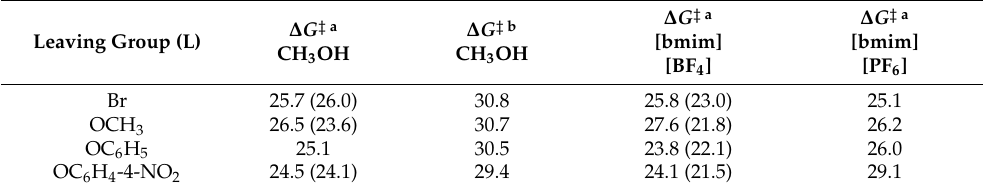
Table 8. Free Energy of Activation, Δ G ‡ (kcal/mol), Calculated at 25 °C for the S N Ar Reactions between the 2-L-5-nitrothiophene (Para-like) Isomers and Piperidine in Methanol and Ionic Liquids (Experimental Energies [77] in Parentheses).